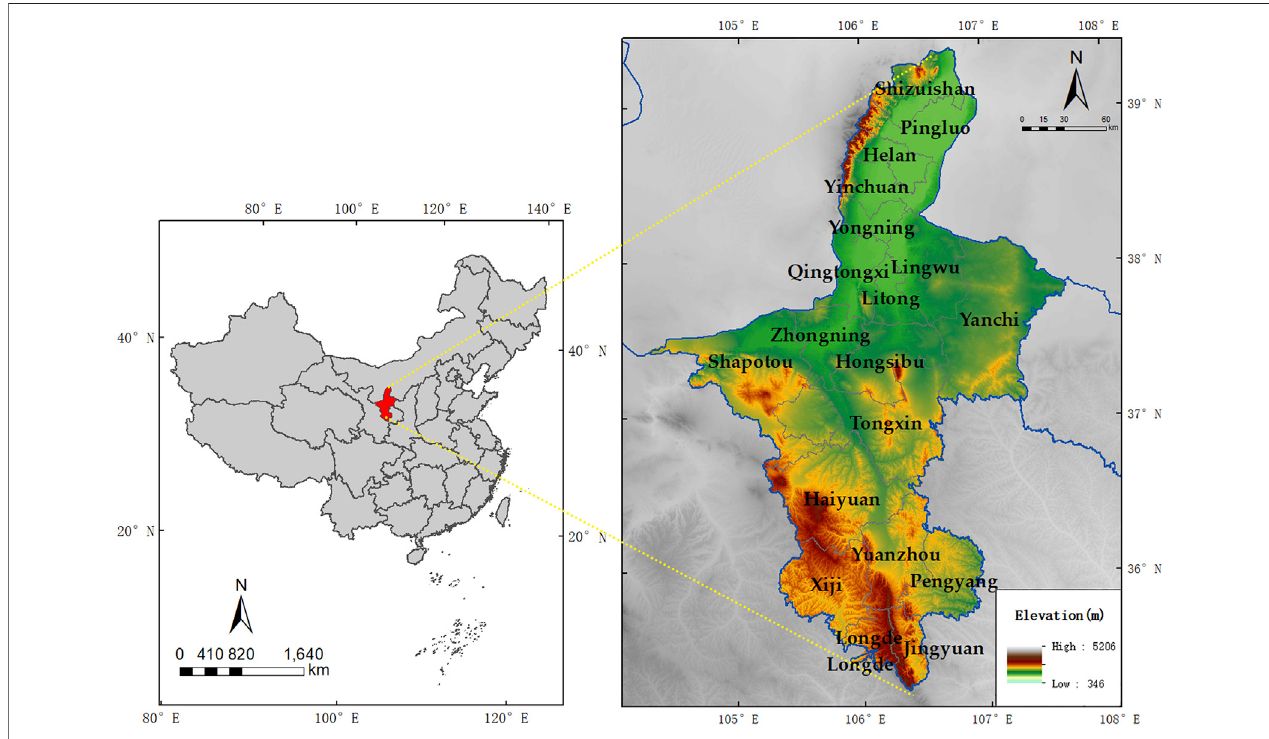
FIGURE 1 | Location and administrative districts of Ningxia, China.